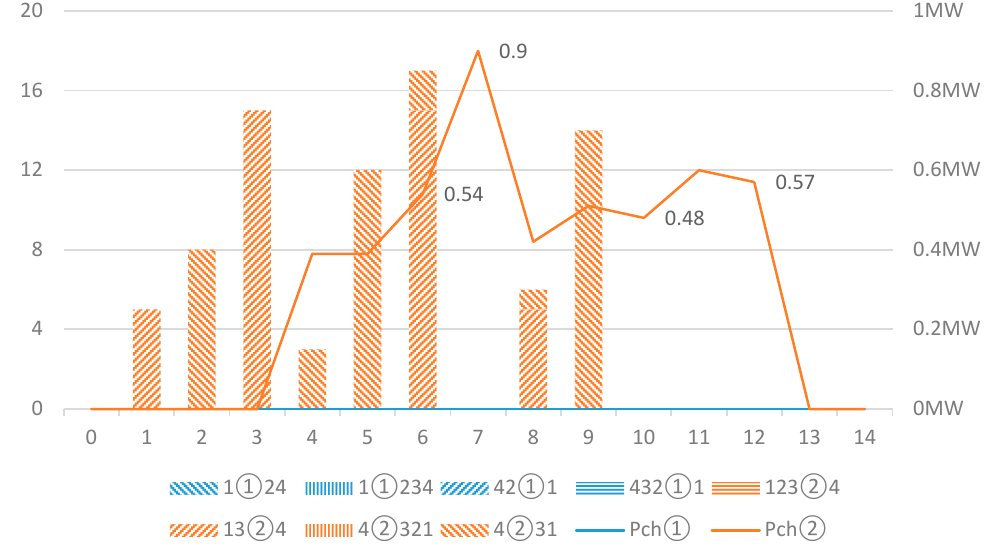
Figure 12. Path assignment of EVs of 2 tasks h (PDN prior, T = 14).